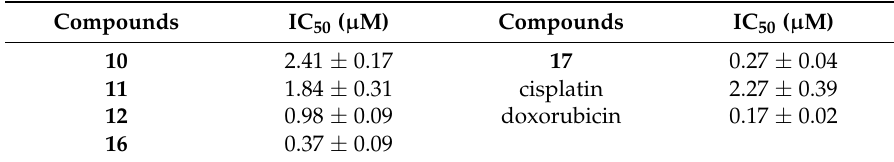
Table 5. Cytotoxic activities of 10 – 12 , 16 , 17 , cisplatin and doxorubicin against A549 cells a